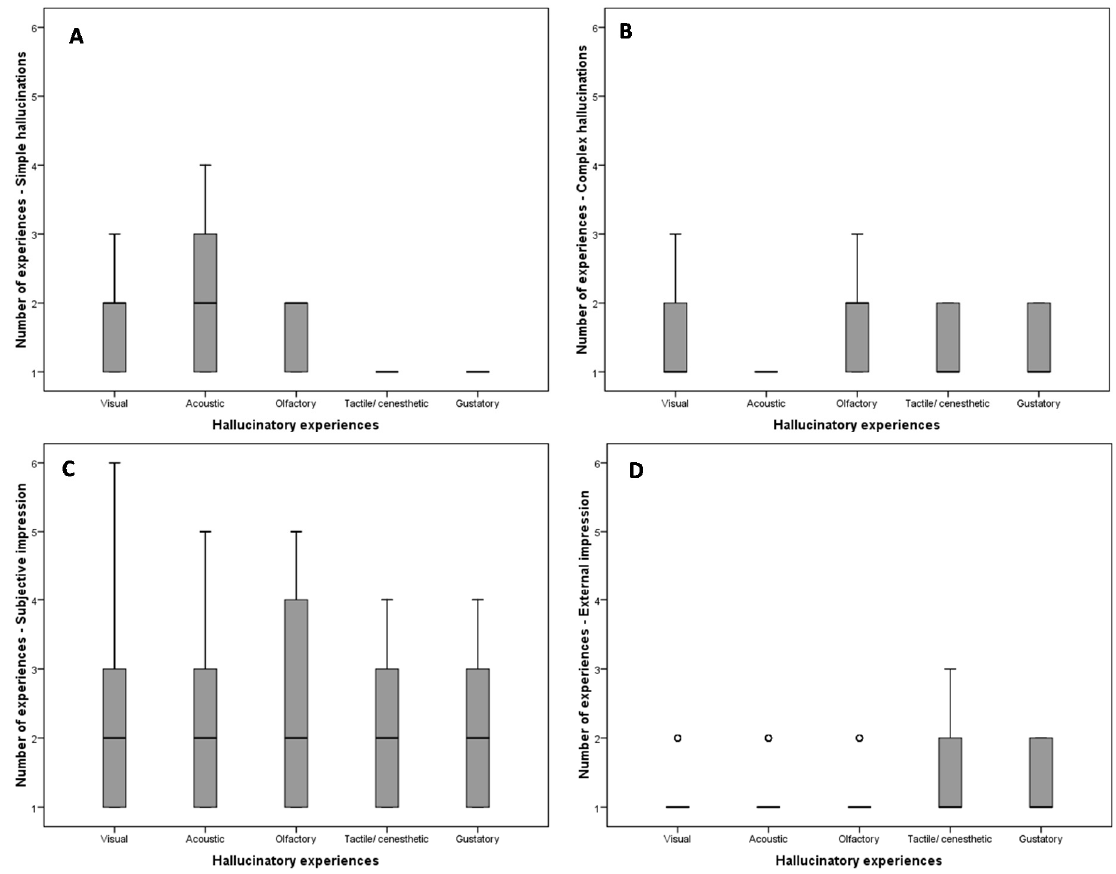
Figure 1. Frequency of individual hallucinations according to whether they are simple ( A ) or complex ( B ), or according to the impression: subjective ( C ) or external ( D ) (° = outliers).